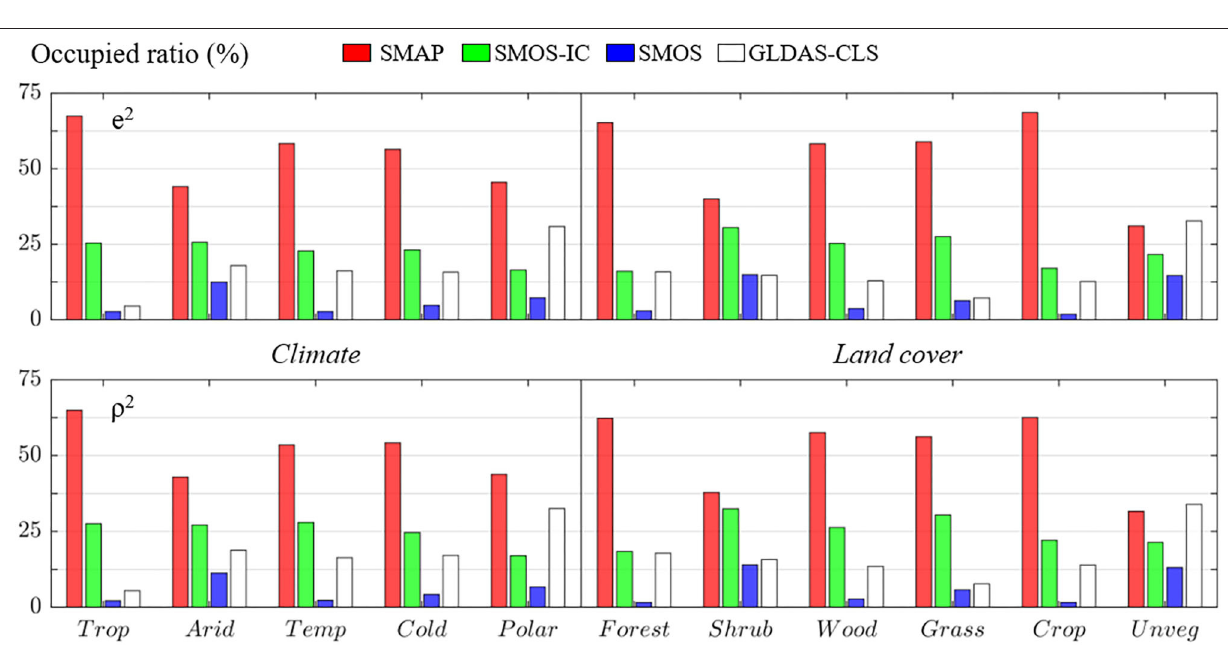
regions. Su et al. (2011) showed increased uncertainty levels of global coarse resolution soil moisture products through comparisons with soil moisture data from the Tibetan Plateau observatory. Ma et al. (2019) presented poor performances of satellite-derived soil moisture data against in situ measurements